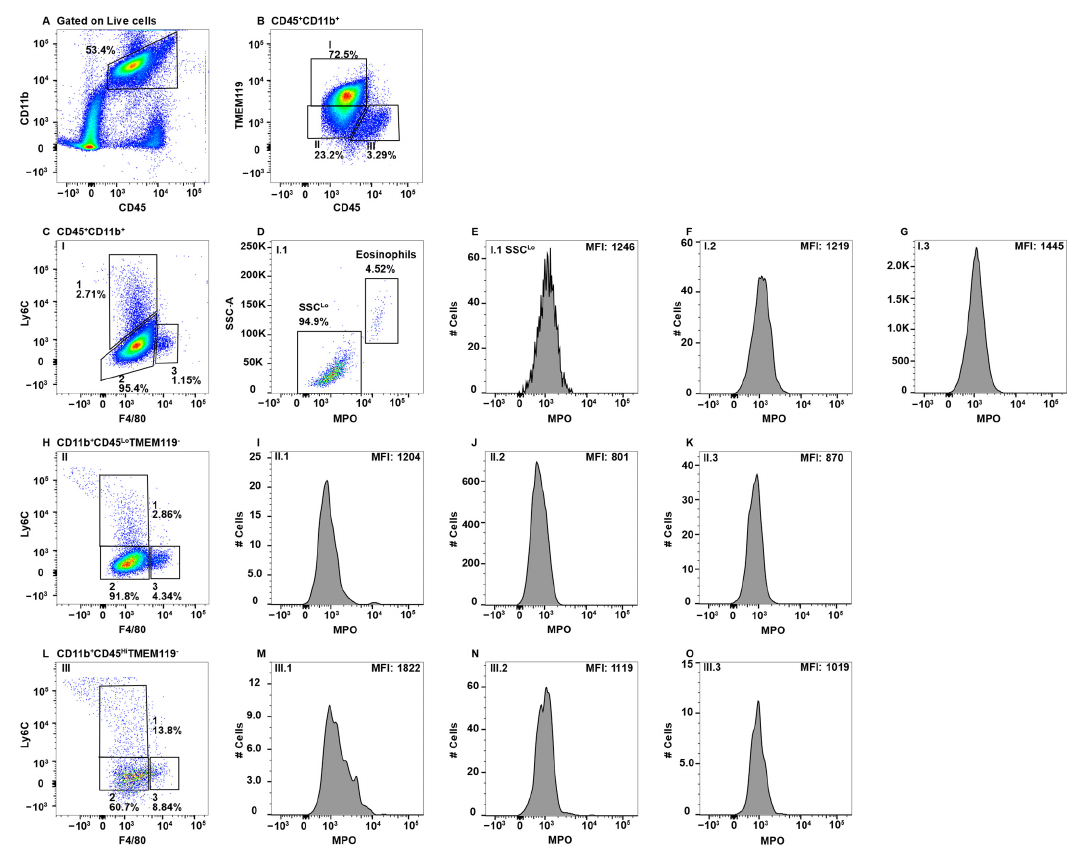
Figure 4. CNS microglial cells and perivascular macrophages do not express MPO. Mononuclear cells from brains and spinal cords were stained with antibodies specific for CD45, CD11b, Ly6C, F4/80, MPO, and TMEM119 and using flow cytometry cells were gated on CD45 + CD11b + ( A ), which were analyzed for TMEM119 expression identifying three Subpop (I-III) ( B ). Subpop I CD45 Lo CD11b + TMEM119 + cells were analyzed for Ly6C and F4/80 expression, which identified three subsets (I.1, I.2, and I.3) ( C ). SSC HI eosinophils were eliminated in Subset I.1 ( D ) prior to analysis of MPO expression ( E ). Subsets I.2 and I.3 did not require eosinophil exclusion before MPO analysis ( F and G , respectively). Subpop II CD45 Lo CD11b + TMEM119 − cells were analyzed for Ly6C and F4/80 expression ( H ), which identified three subsets (II.1, II.2, and II.3), which were further analyzed for MPO expression ( I , J , K , respectively). Subpop III CD45 Hi CD11b + TMEM119 − cells analyzed for Ly6C and F4/80 expression identified three subsets (III.1, III.2, and III.3) ( L ), which were further analyzed for MPO expression ( M,N , O , respectively). The percent positive cells in dot plot gates and the MFI of histograms is provided. Data shown are representative of three mice.